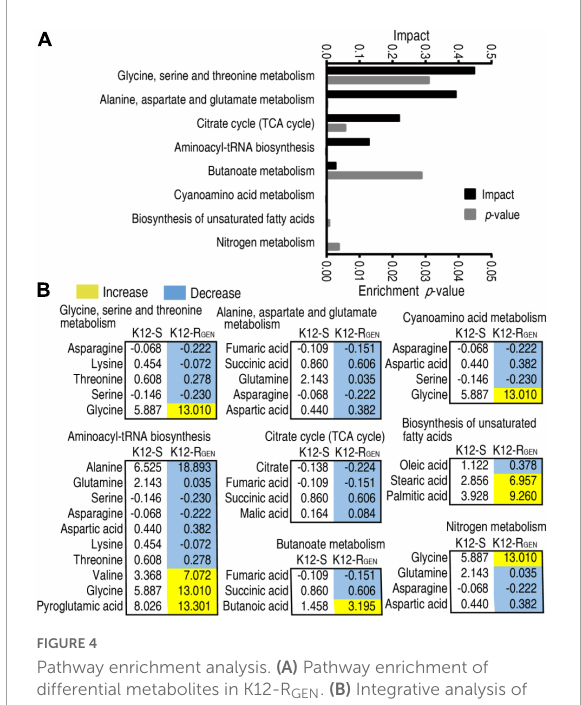
FIGURE4 Pathway enrichment analysis. (A) Pathway enrichment of differential metabolites in K12-R GEN . (B) Integrative analysis of metabolites in significantly enriched pathways. Yellow and light blue indicate increased and decreased metabolites,